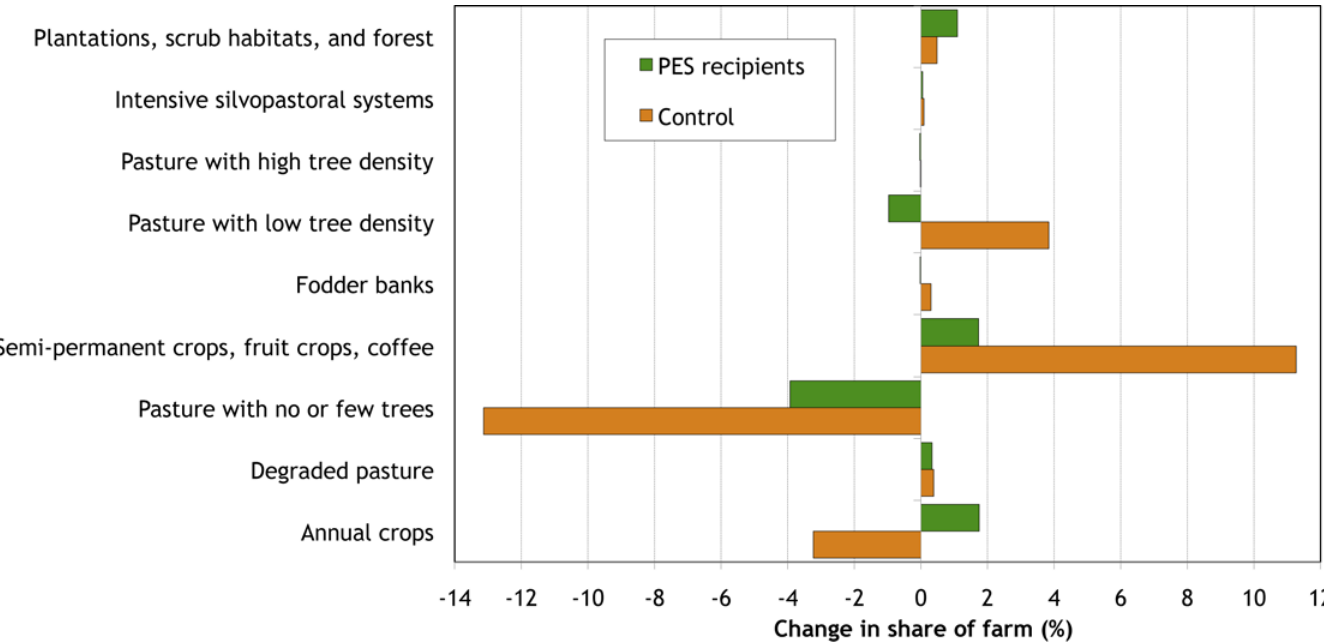
Fig 3. Observed changes in land use in post-PES period in Quindío, Colombia, 2007 to